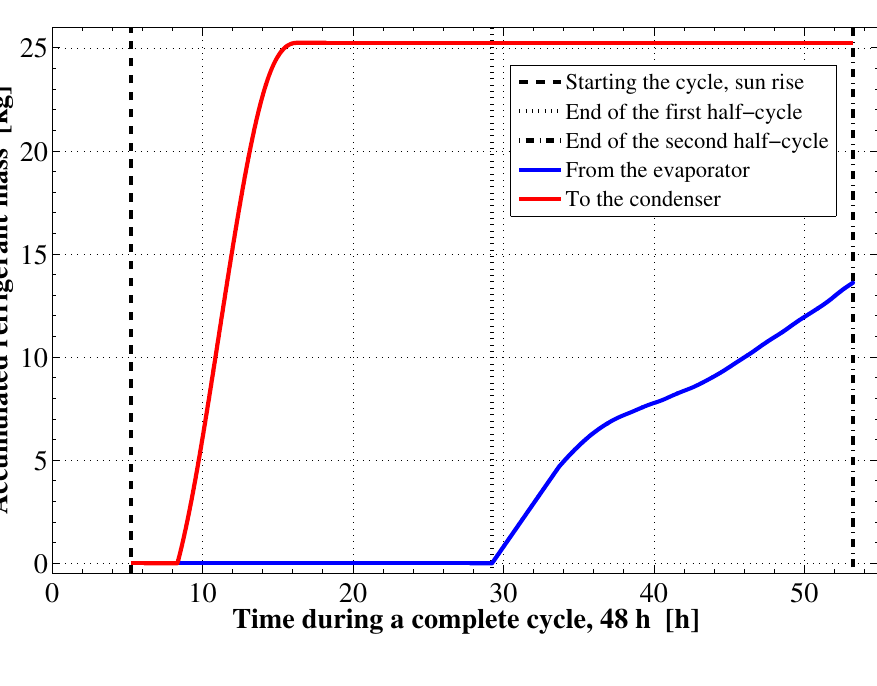
Figure 7. The time integrated refrigerant vapor mass into and out of the